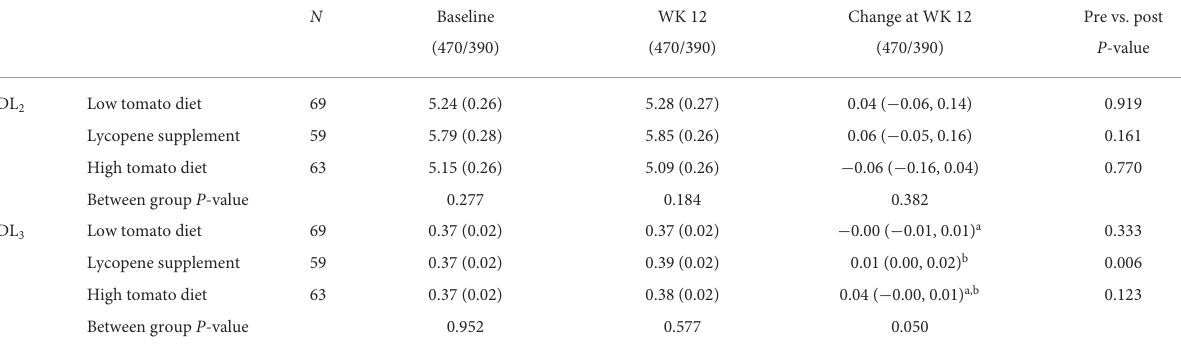
TABLE 5 LCAT activity in HDL 2 and HDL 3 following 12-week intervention with either a low tomato diet, lycopene supplement, or high tomato diet.